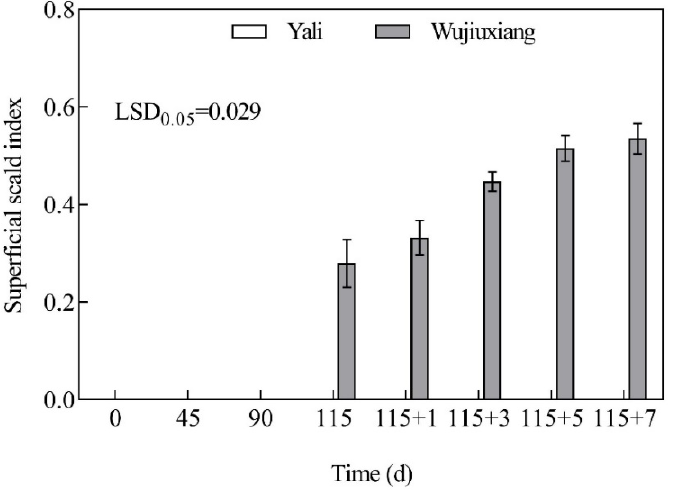
Figure 1. Superficial scald indexes of ‘Yali’ and ‘Wujiuxiang’ pear during cold storage and the shelf life period. Vertical bars represent standard errors and the LSD values show significant differences at the 0.05 level. Note: 115 + 1, 115 + 3, 115 + 5, and 115 + 7 represent 1, 3, 5, and 7 days of shelf life at room temperature (20 °C) after cold storage at 0 °C for 115 days.